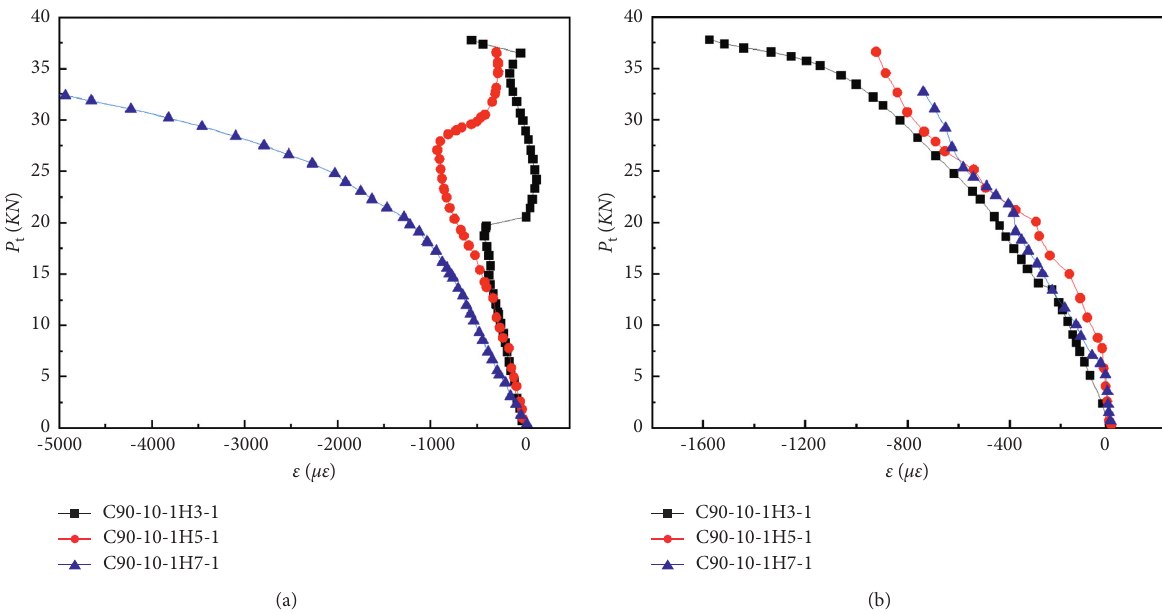
Figure 13: Load versus strain curves for section C90-10 with different circular hole sizes. (a) Strain gauge 4. (b) Strain gauge